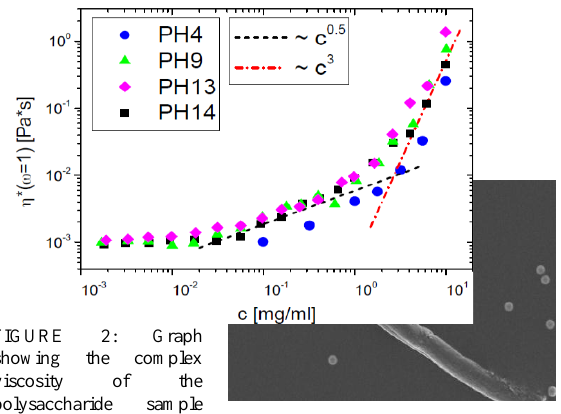
FIGURE 2: Graph showing the complex viscosity of the polysaccharide sample versus its concentration. Dotted lines show scaling laws, indicating different regimes of behavior as the sample concentration is varied. The scaling laws indicate rod-like molecules in solution [3], which is backed up by SEM images of the sample (Figure 3). FIGURE 3: SEM images of the capsular polysaccharide sample at a low concentration, surrounded by probe beads